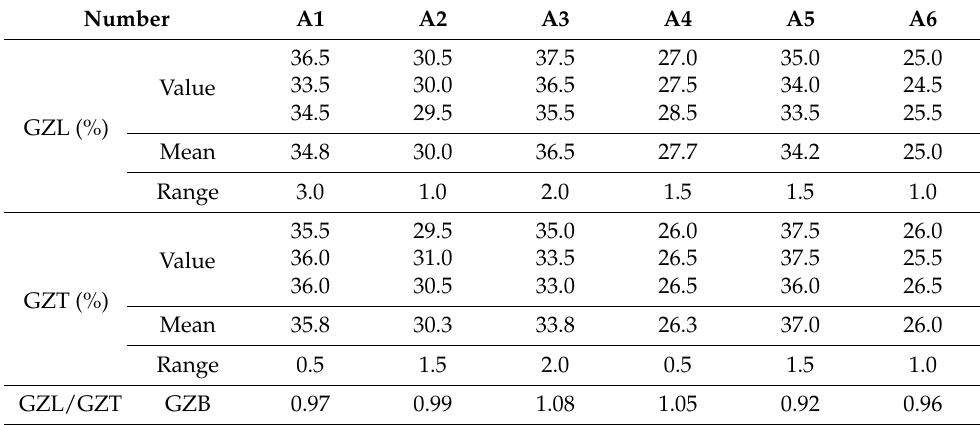
Table 5. The measured value of gloss for Group